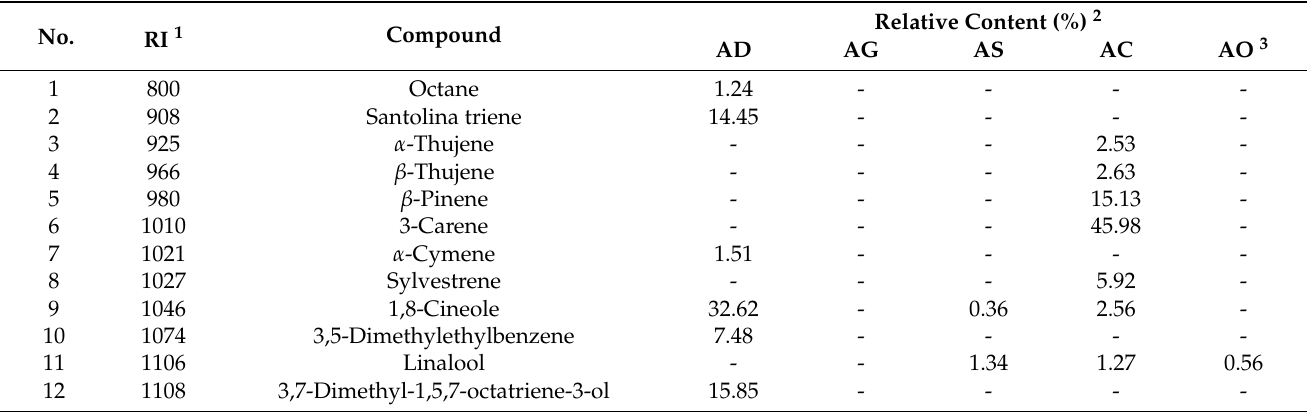
Table 1. Chemical composition of essential oils extracted from the five Artemisia